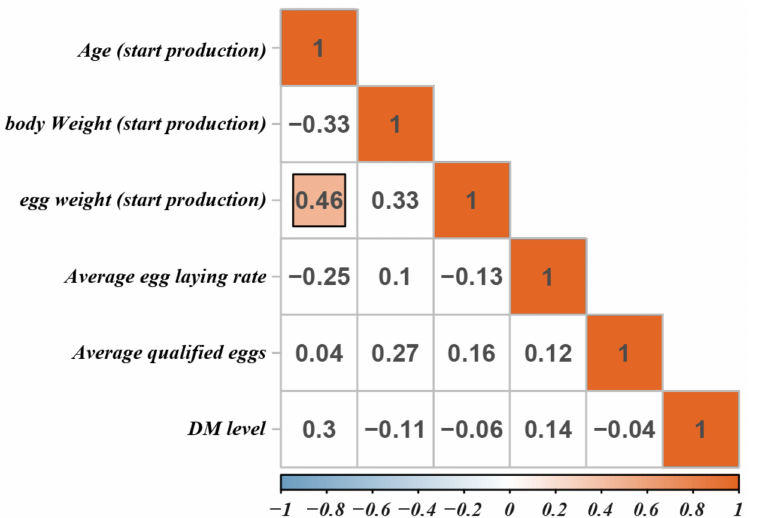
Figure 3. The correlation of high DM level and production performance. Blank background color indicates not significant. The darker the color, the greater the